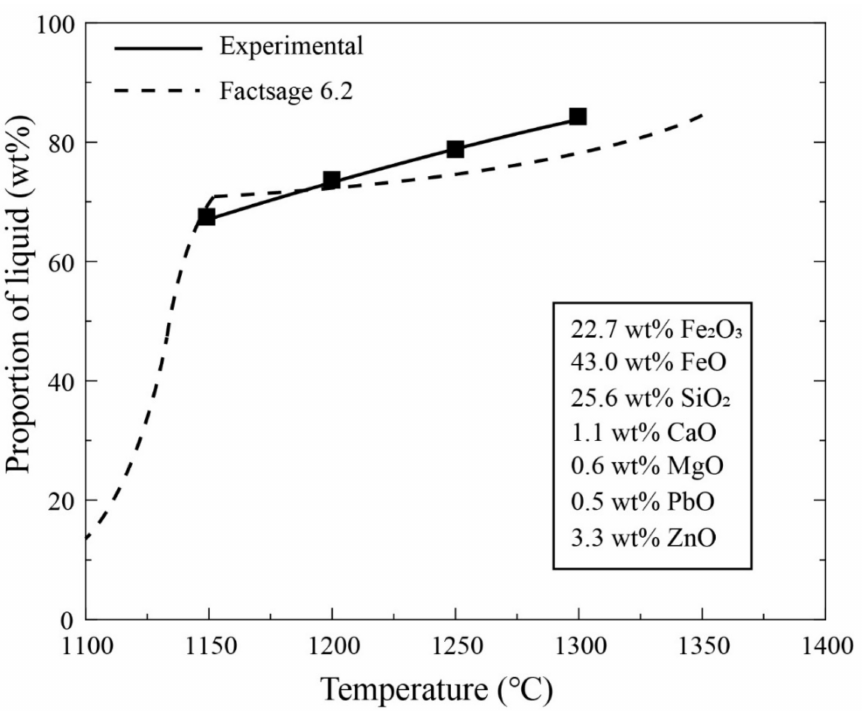
Figure 5. Proportion of liquid as a function of temperature for a typical BBF slag, in comparison between experimental results and FactSage 6.2 predictions. Reprinted with permission from ref. [7]. Copyright 2021 John Wiley and Sons.